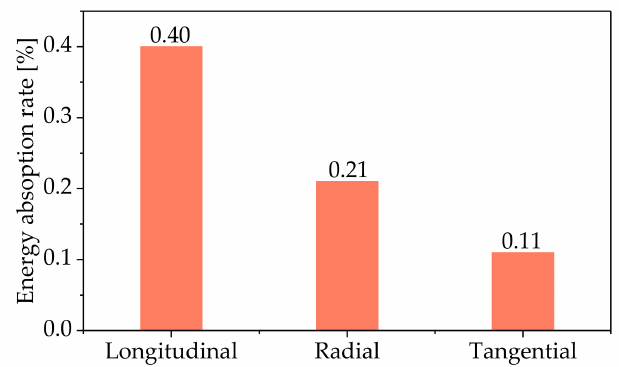
Figure 7. The energy absorption efficiency of the wood in different